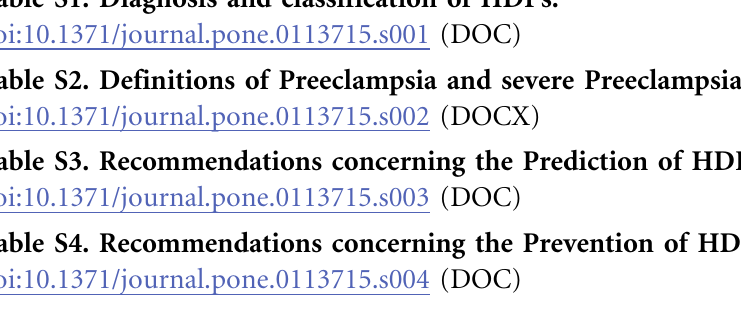
Table S1. Diagnosis and classification of HDPs. Table S2. Definitions of Preeclampsia and severe Preeclampsia. Table S3. Recommendations concerning the Prediction of HDP. Table S4. Recommendations concerning the Prevention of